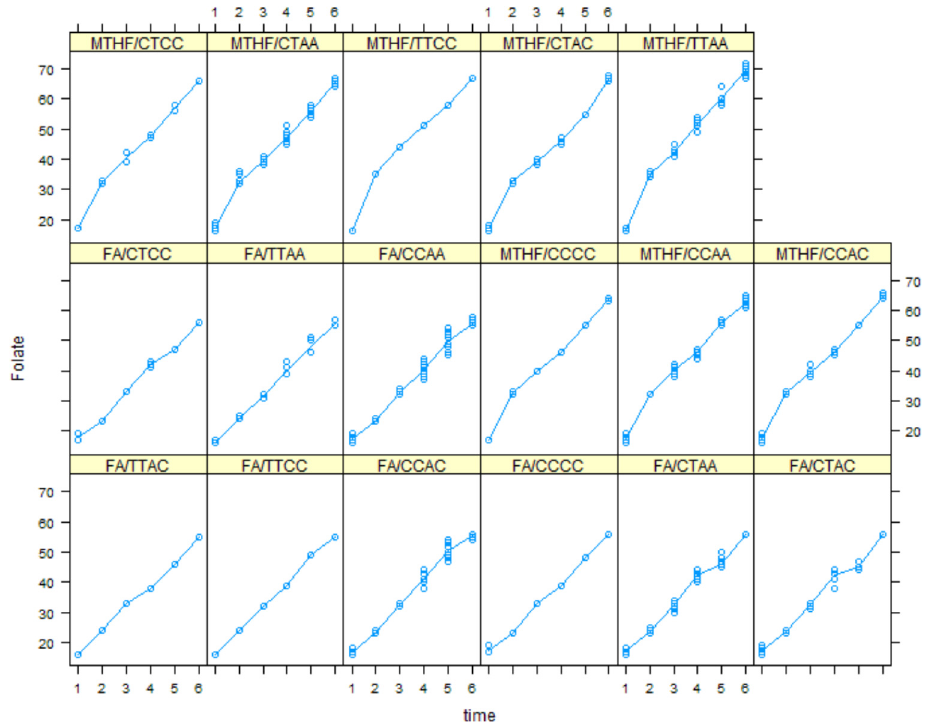
Fig 4. Serum folate concentration in folic acid and MTHFR groups in different MTHFR polymorphisms over time.